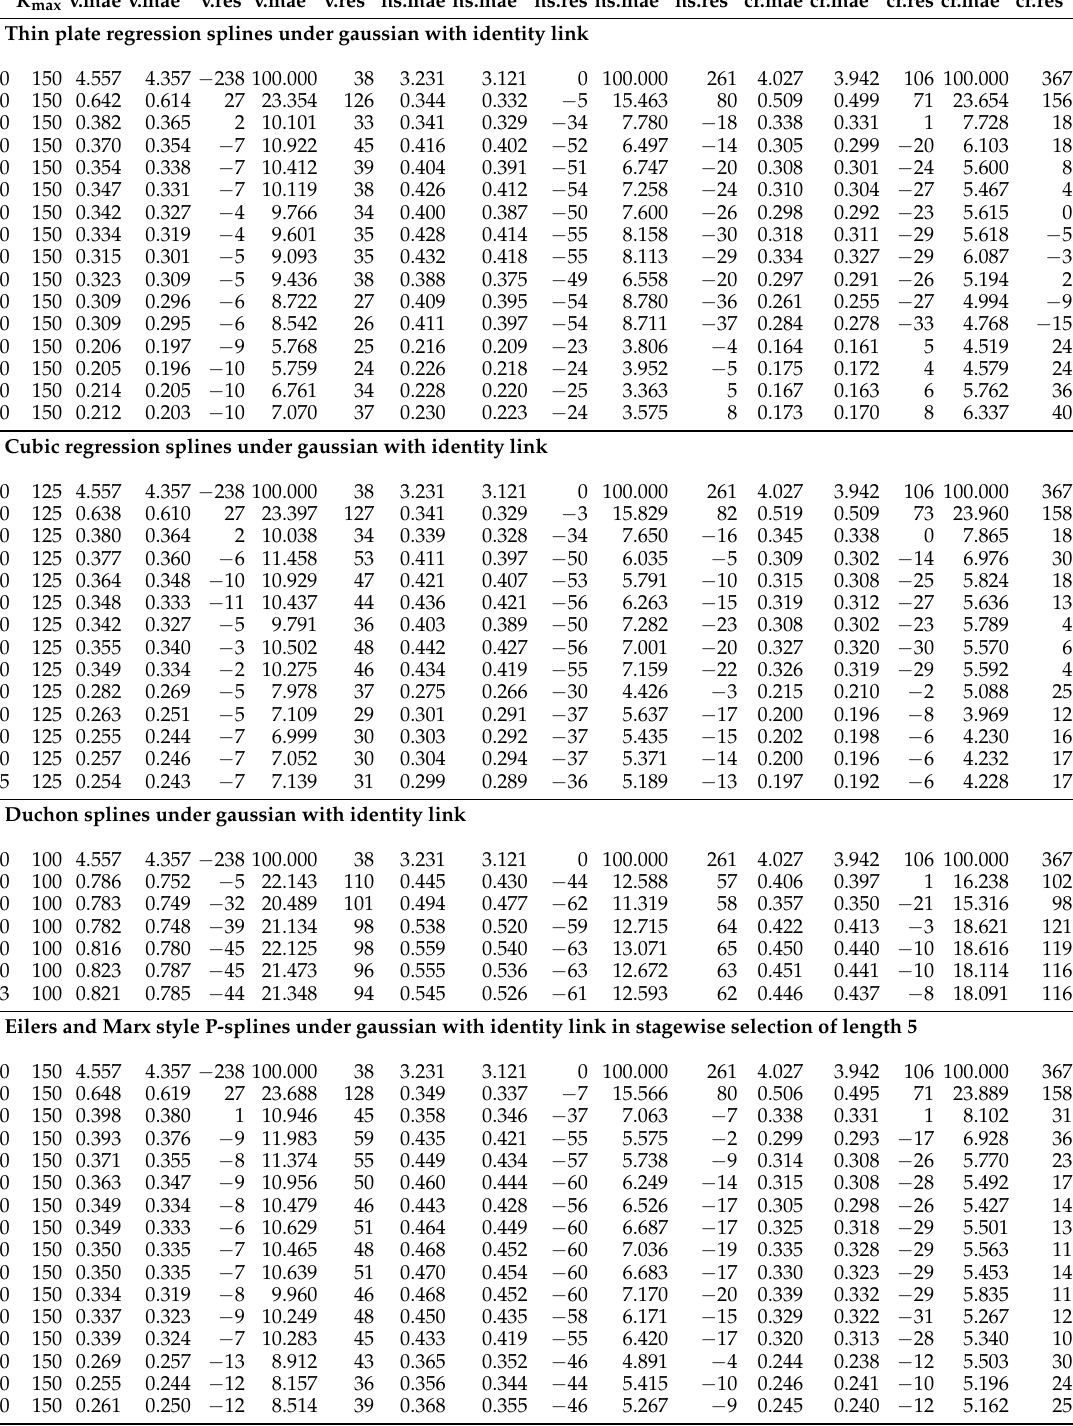
Table A18. Out-of-sample validation figures of selected GAMs of BEL with varying spline function type and fixed spline function number of 10 per dimension under between 100–443 and 150–443 after each tenth and the finally selected smooth